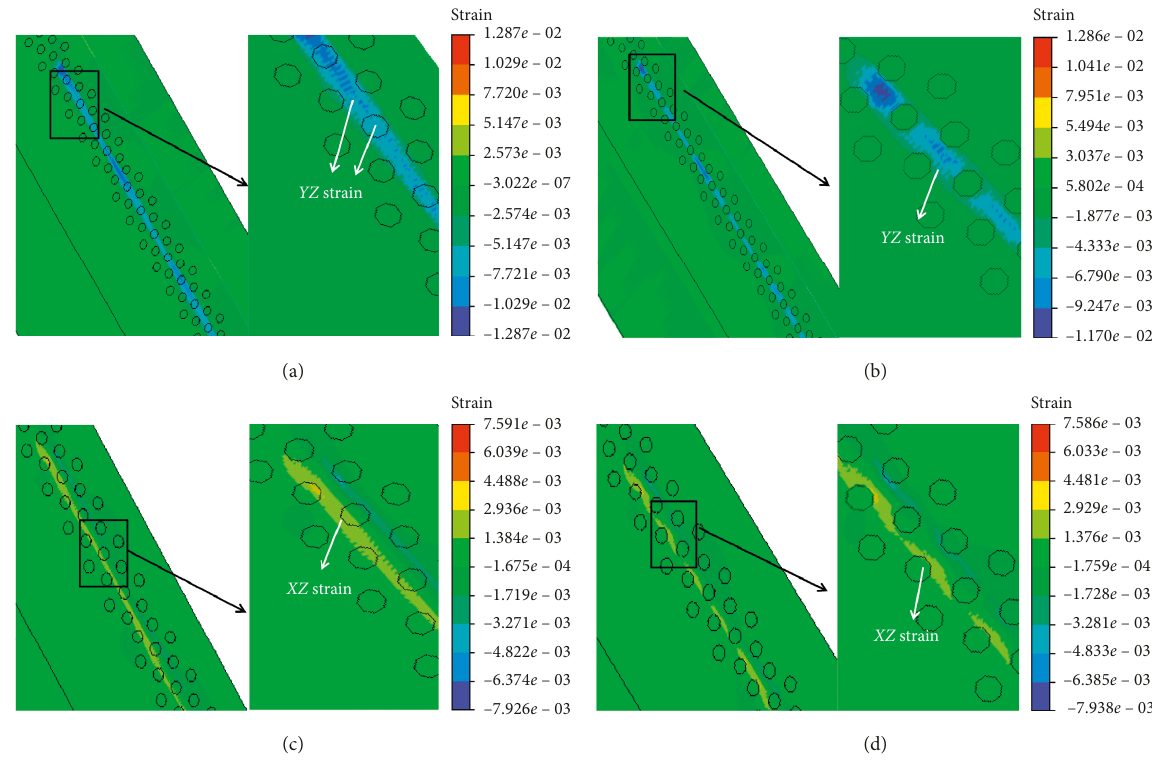
Figure 18: Field of shear strain on the rail: (a) yz strain with nonhardening material; (b) yz strain with hardening material; (c) xz strain with nonhardening material; (d) xz strain with hardening material.